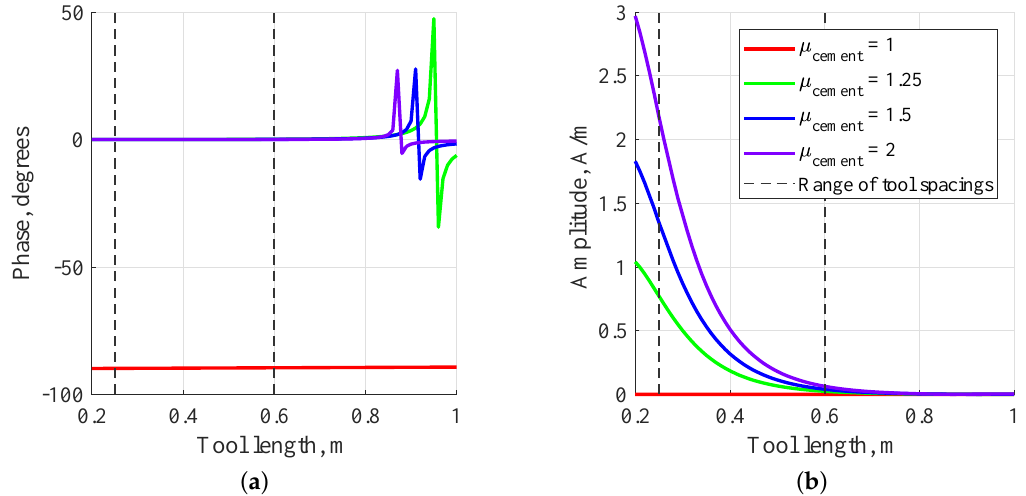
Figure 4. Effect of magnetic permeability of cement on induction logging signals at the frequency of 1 kHz: ( a ) Phase vs. tool length. ( b ) Amplitude vs. tool